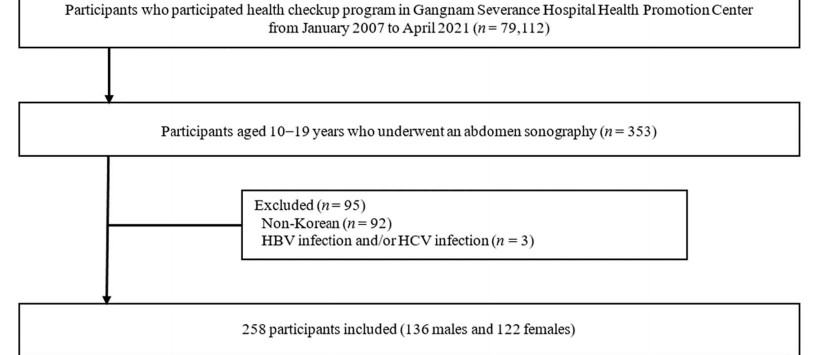
Figure 1. Design and flowchart of the study population. HBV, hepatitis B virus; HCV, hepatitis C virus.